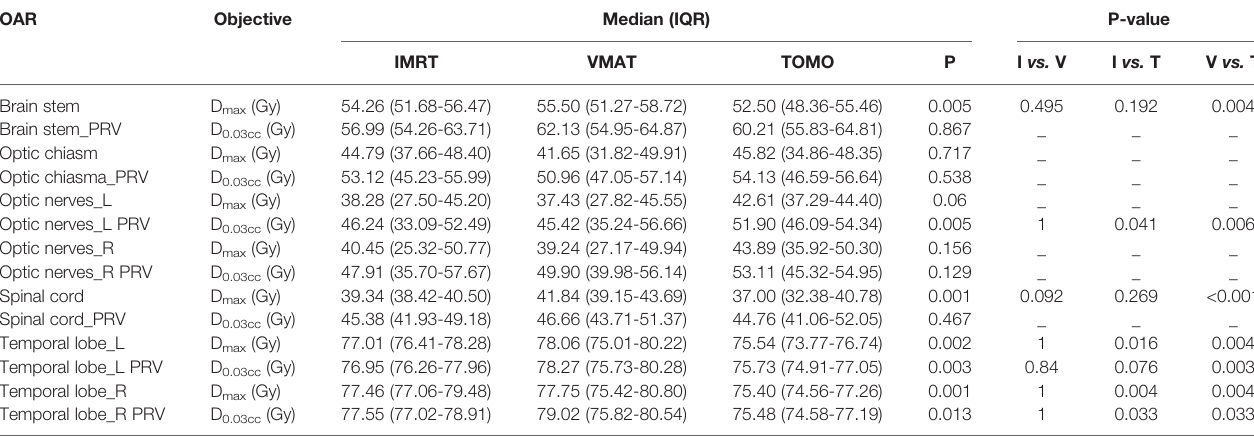
TABLE 9 | Comparison of organs at risk (priority level I and II) in T 3-4 NPC patients.